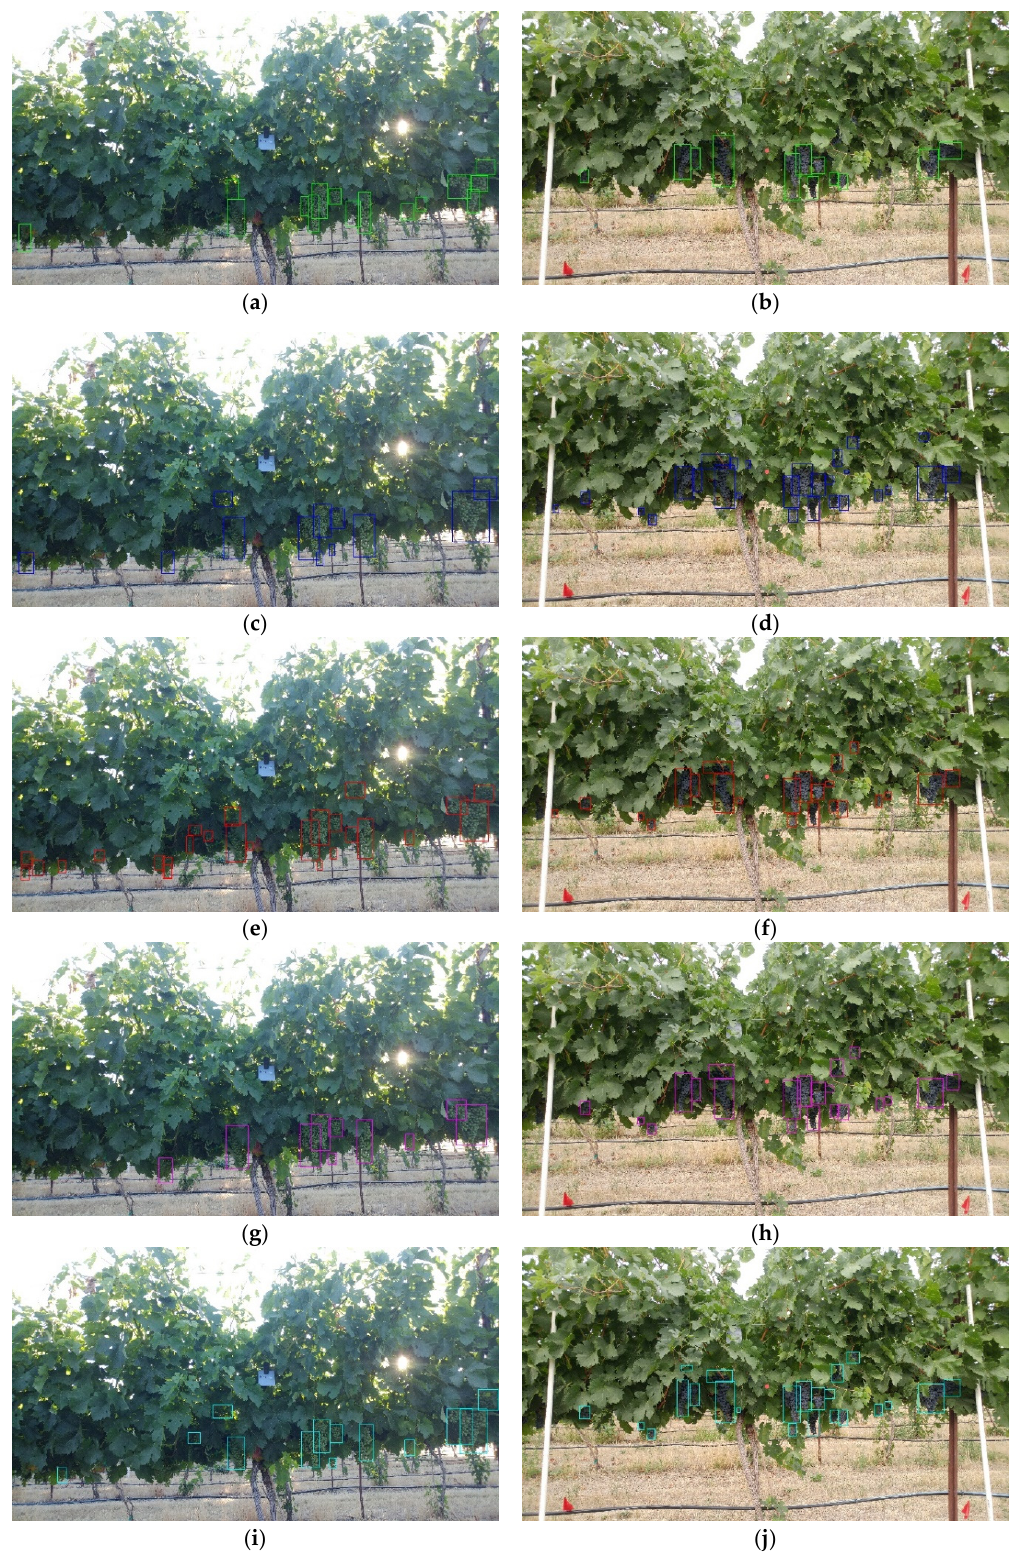
Figure A4. Demonstrations of detection results on the test set of Merlot (red variety) using ( a , b ) Faster R-CNN (bounding boxes in green color); ( c , d ) YOLOv3 (in blue color); ( e , f ) YOLOv4 (in red color); ( g , h ) YOLOv5 (in magenta color); and ( i , j ) Swin-transformer-YOLOv5 (in cyan color) at immature (left) and mature (right) stages.